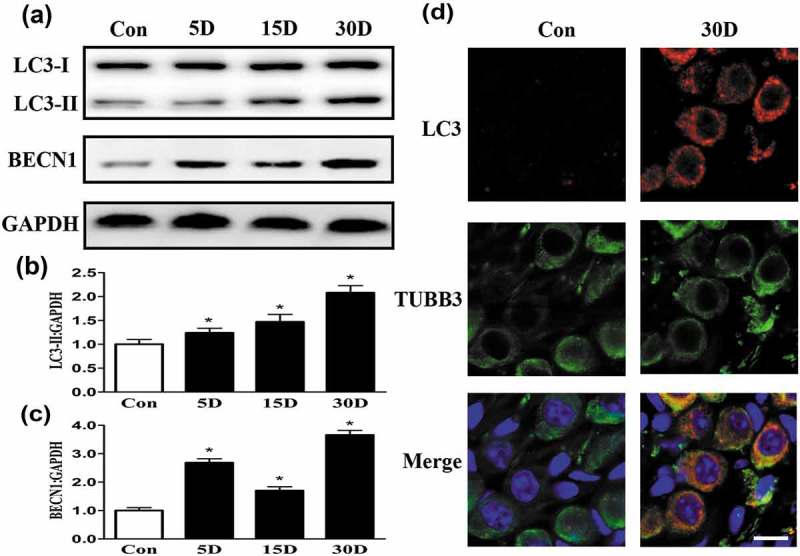
The autophagy level was increased in degenerated mouse SGNs. (a-c) Western blot results revealed that the levels of the autophagy-related proteins LC3 and BECN1 were increased in the degenerated SGNs on the 5th, 15th and 30th day after ototoxic drug administration and were significantly different from those in the normal mice. *, P < 0.05. (d) Immunofluorescence staining of LC3 puncta (red) also demonstrated that the LC3 level in the degenerated SGNs (green) was significantly increased on the 30th day after drug administration. Con, normal mice without drug treatment; 30D, 30 days after drug administration. Images of immunofluorescence staining were taken from the middle turn of cochlea. Scale bar: 10 µm.